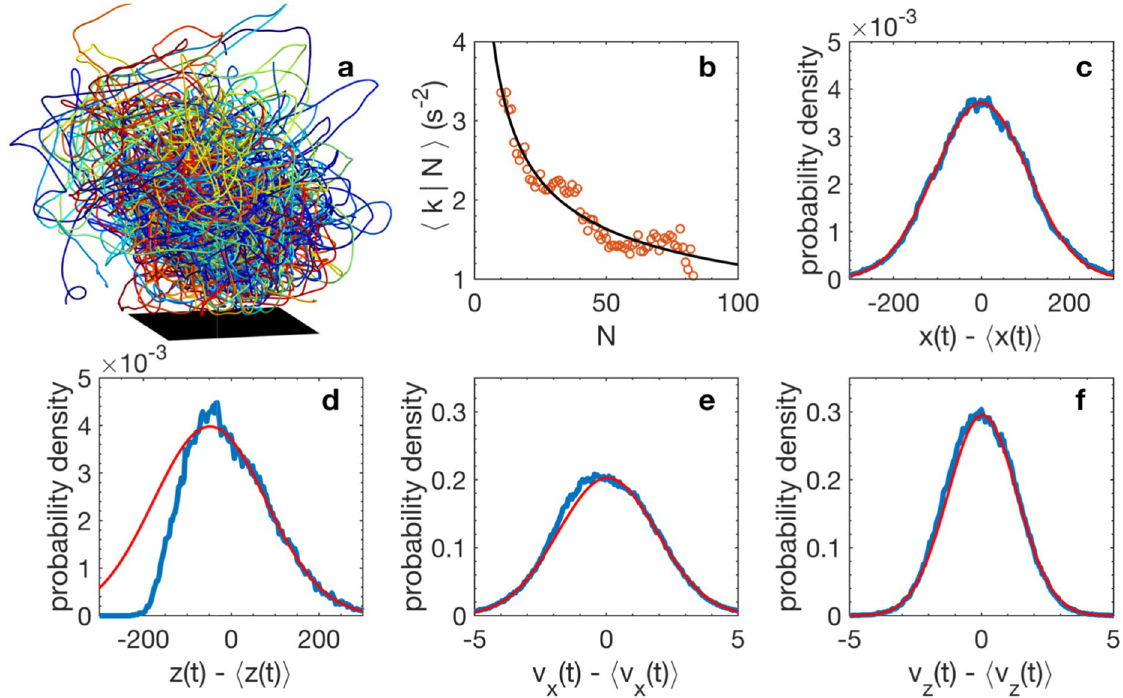
Figure 1. Swarm kinematics. ( a ) Trajectories (> 40 s long) of individual midges (each colour corresponding to a different midge) are individually convoluted but remain spatially localized over a ground-based swarm marker (black square). ( b ) Averaged spring constant � k | N � as function of the swarm size N (symbols). The black line is a power-law fit to the data. ( c ) Probability density function (PDF) of midge positions in the horizontal plane (blue) along with a Gaussian fit to the data (red). ( d ) PDF of midge positions in the vertical (gravity) direction (blue) and a Gaussian fit to the data (red). The deviation from Gaussianity in the vertical component of the position arises from the symmetry breaking due to the bottom floor of the experimental setup. ( e , f ) PDFs of the horizontal ( e ) and vertical ( f ) midge velocities (blue) along with Gaussian fits to the data